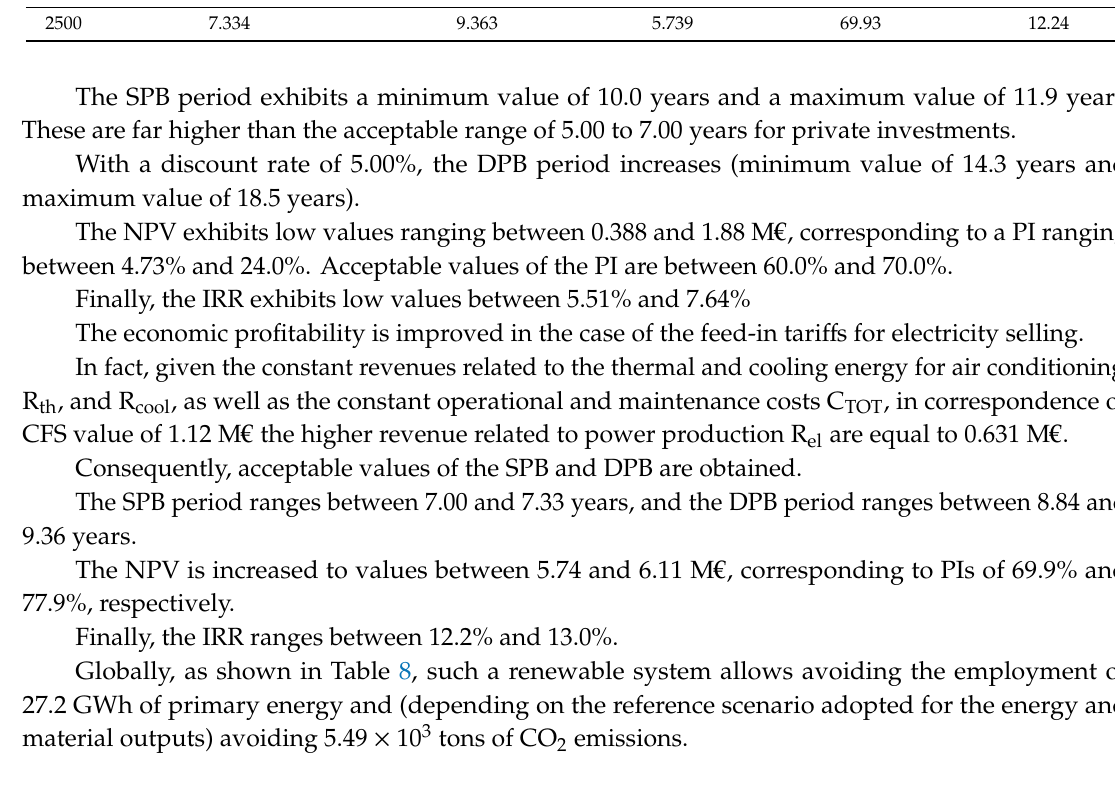
Table 8. Saved primary energy and CO 2